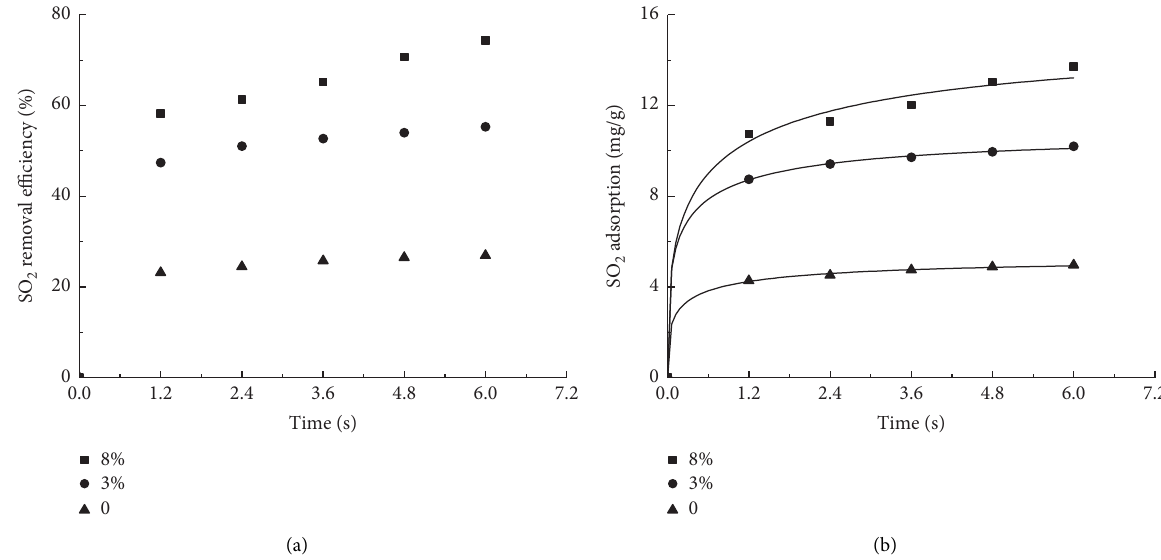
Figure 9: Influence of H 2 O concentration on (a) SO 2 removal rate and (b) SO 2 adsorption. The temperature is 65 and SO 2 and O 2 concentration is 0.085% and 6%.